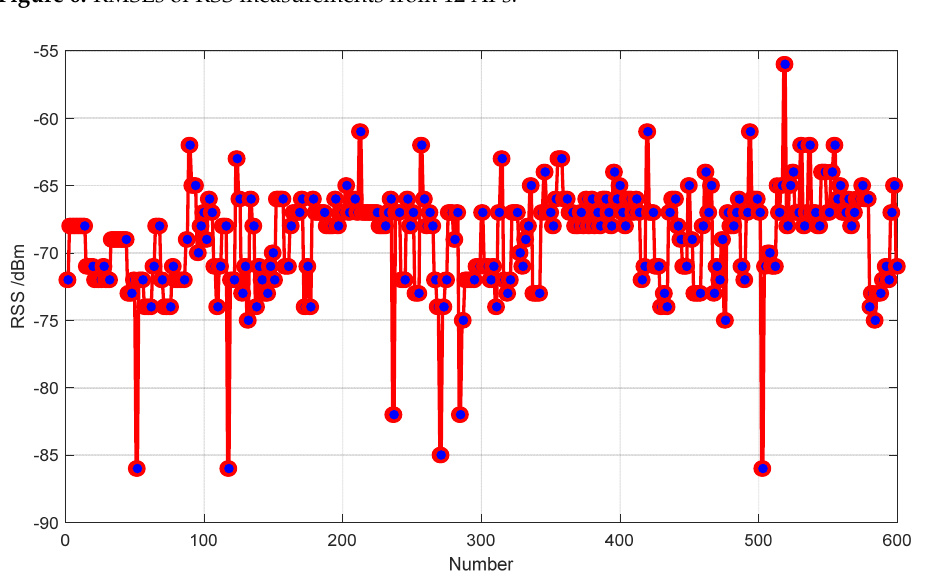
Figure 7. 600 groups of RSS measurements of the AP 6.